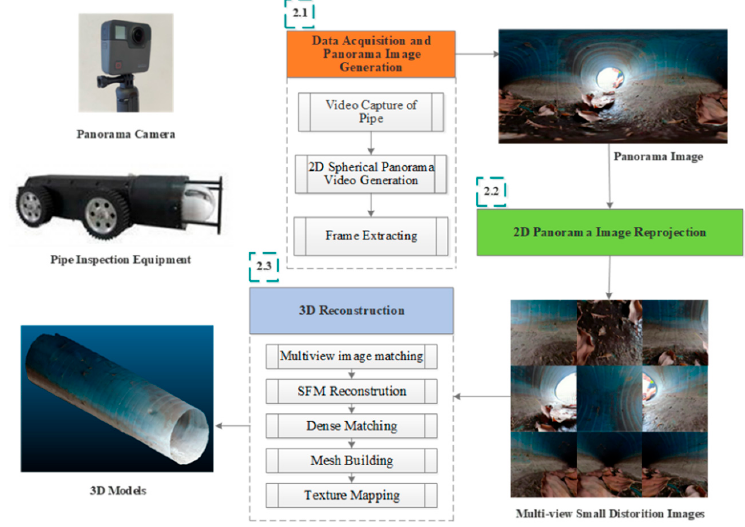
Figure 1. Pipe reconstruction technological